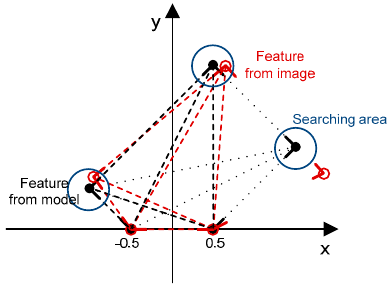
Figure 6. Context features to be used for calculating score function.